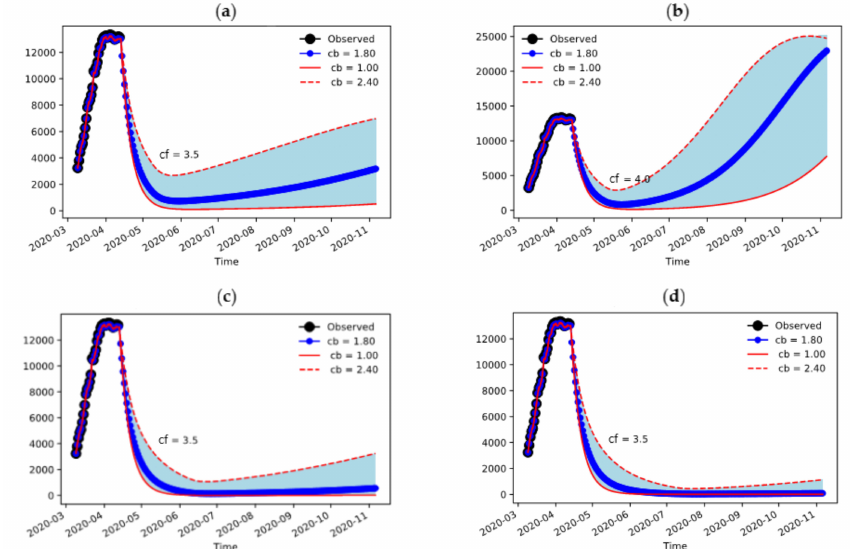
Figure 4. Sensitivity to final confinement value and duration of containment measures: ( a ) Final value of 3.5 contacts / day and containment lasting 60 days; ( b ) Final value of 4.0 contacts / day and containment lasting 60 days; ( c ) Final value of 3.5 contacts / day and containment lasting 90 days; ( d ) Final value of 3.5 contacts / day and containment lasting 120